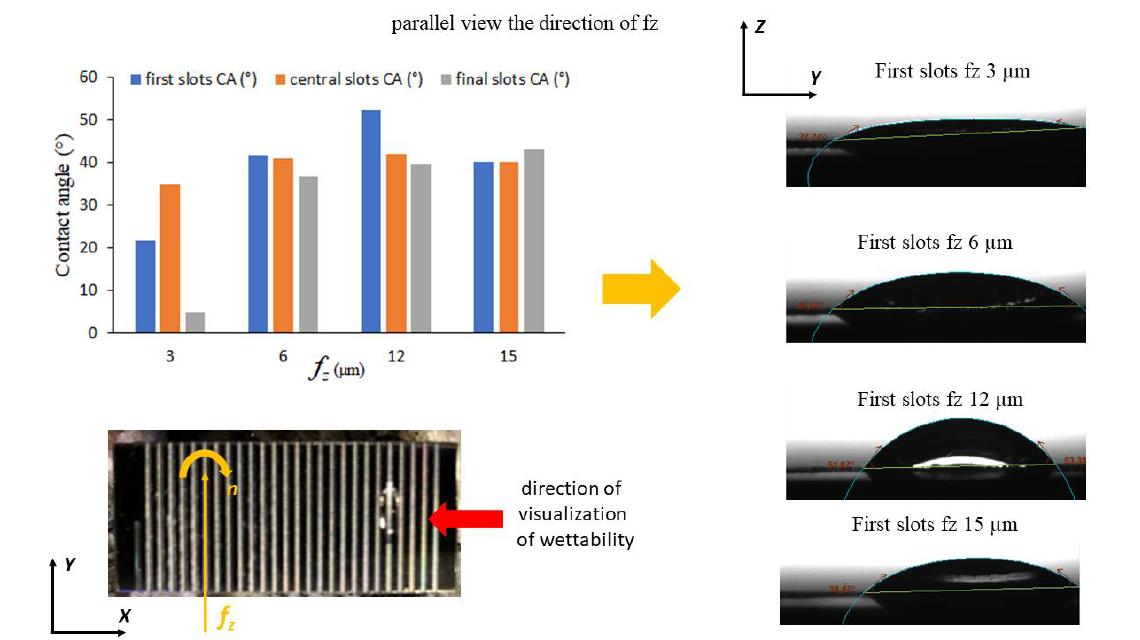
Figure 8: Contact angle as a function of fz and channel